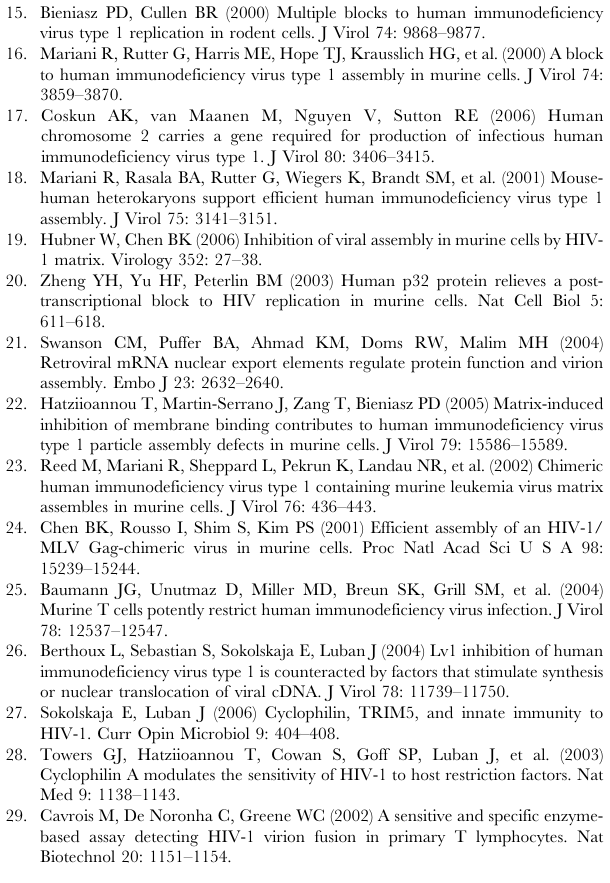
Figure S1 VSVG mediates efficient entry into mouse and human T cells. Entry assay for VSVG-pseudotyped HIV-1 containing Vpr- b -lactamase at MOI of 0.04 was performed as described in the legend to Figure 1. Figure S2 Benzonase treatment did not affect the infectivity of HIV-1. Dilutions of the viruses before and after benzonase